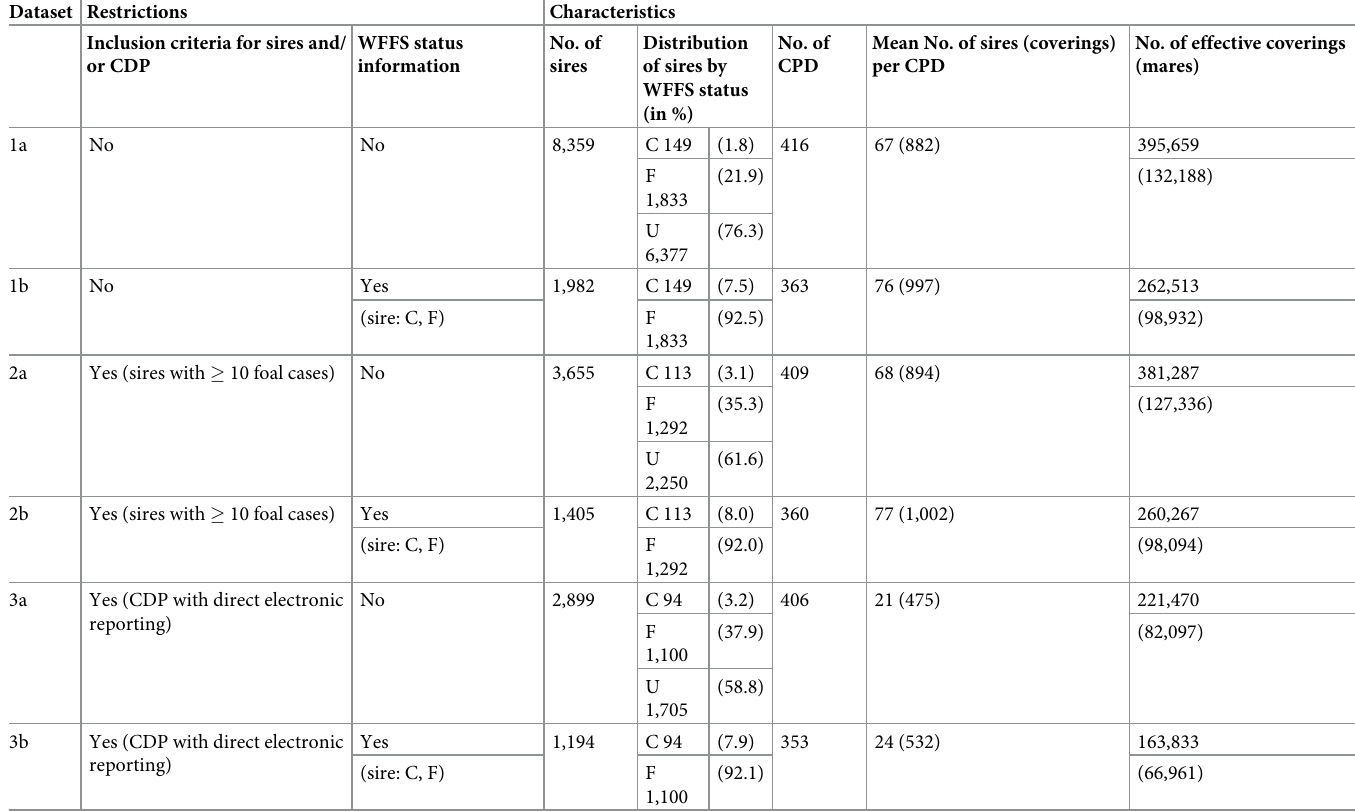
Table 1. Characteristics of the datasets used for the statistical analyses of covering data regarding WFFS effects from 10 German studbooks of riding horses, in dependence of the applied